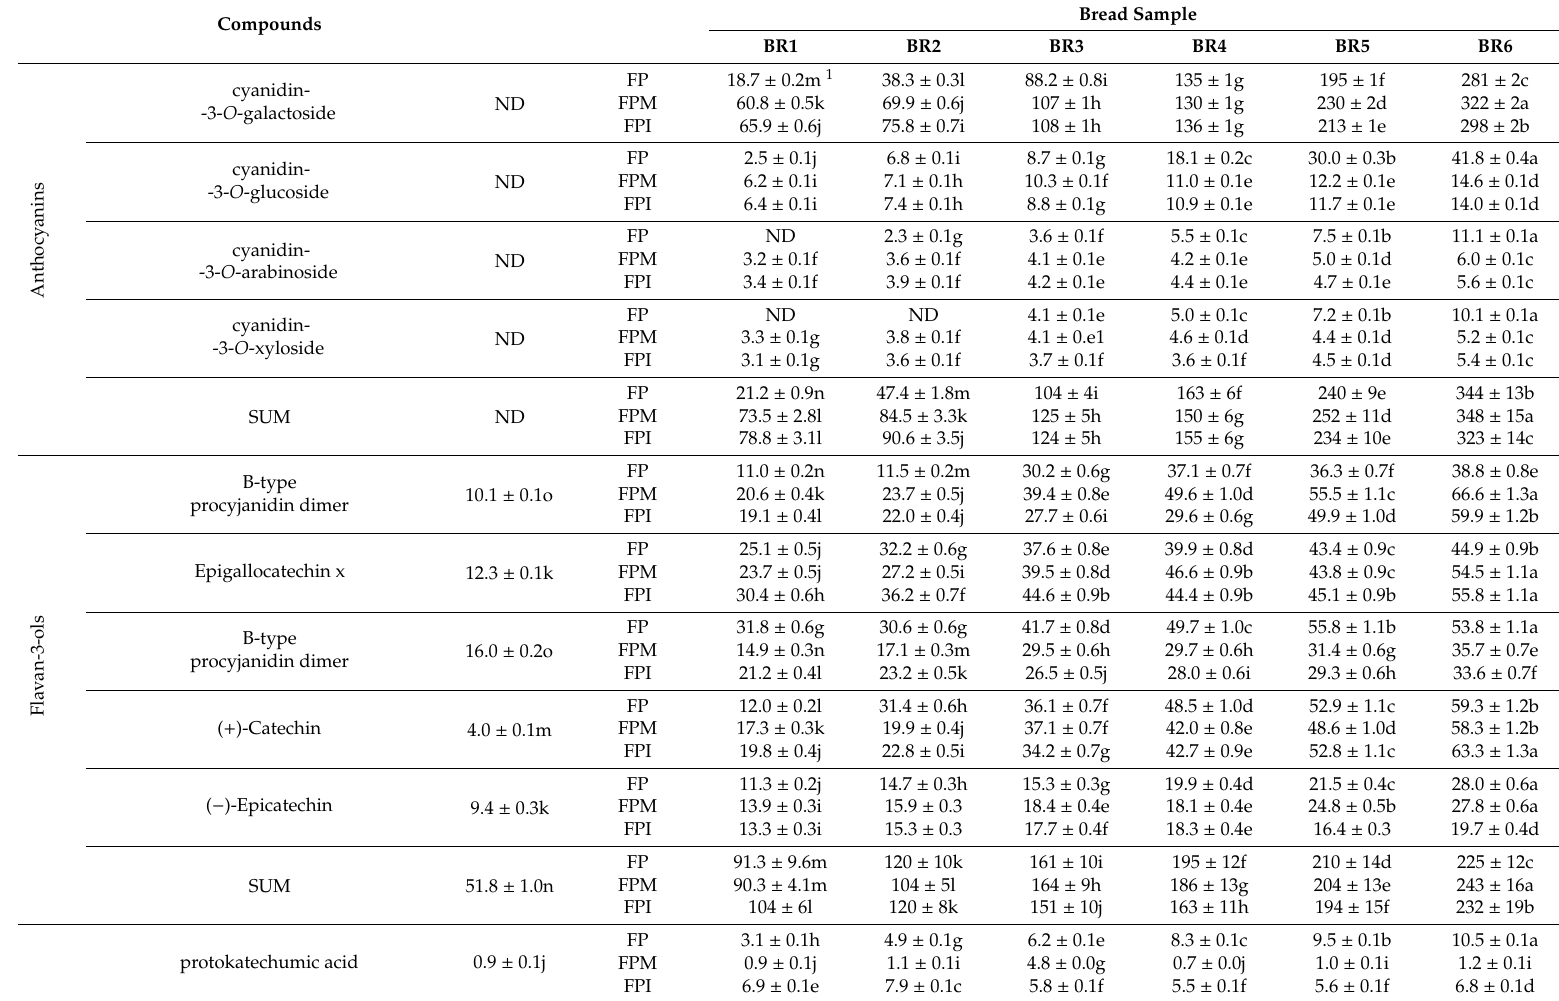
Table 2. The content of polyphenols in rye bread [mg / 100 g